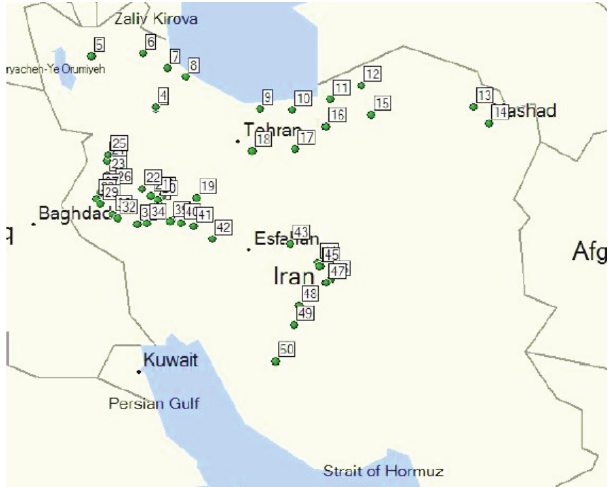
Fig. 1 - Map showing the sampling locations of common bermu- dagrass accessions from different regions of Iran.